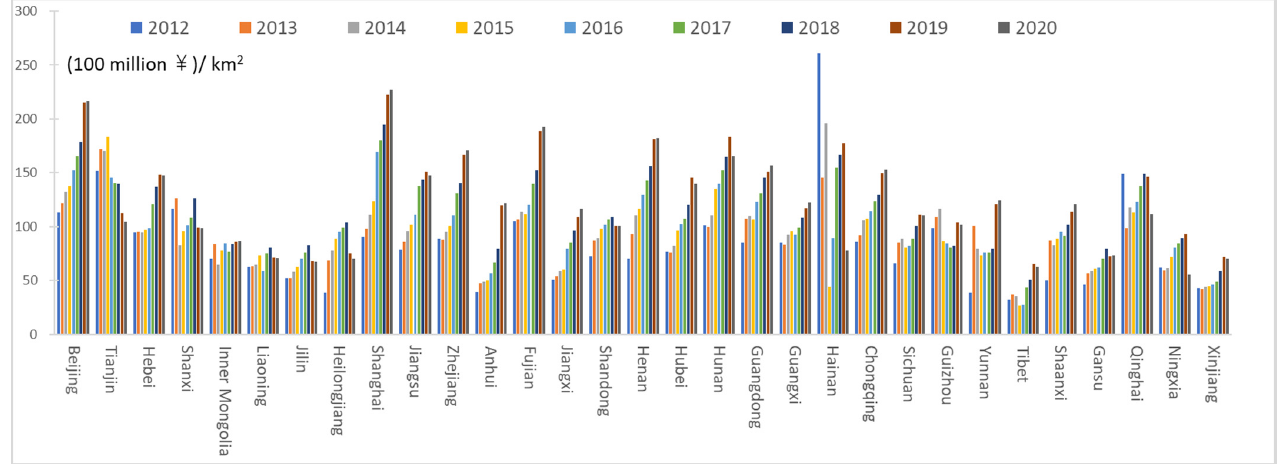
Figure 11. Analysis of change of per area added value.